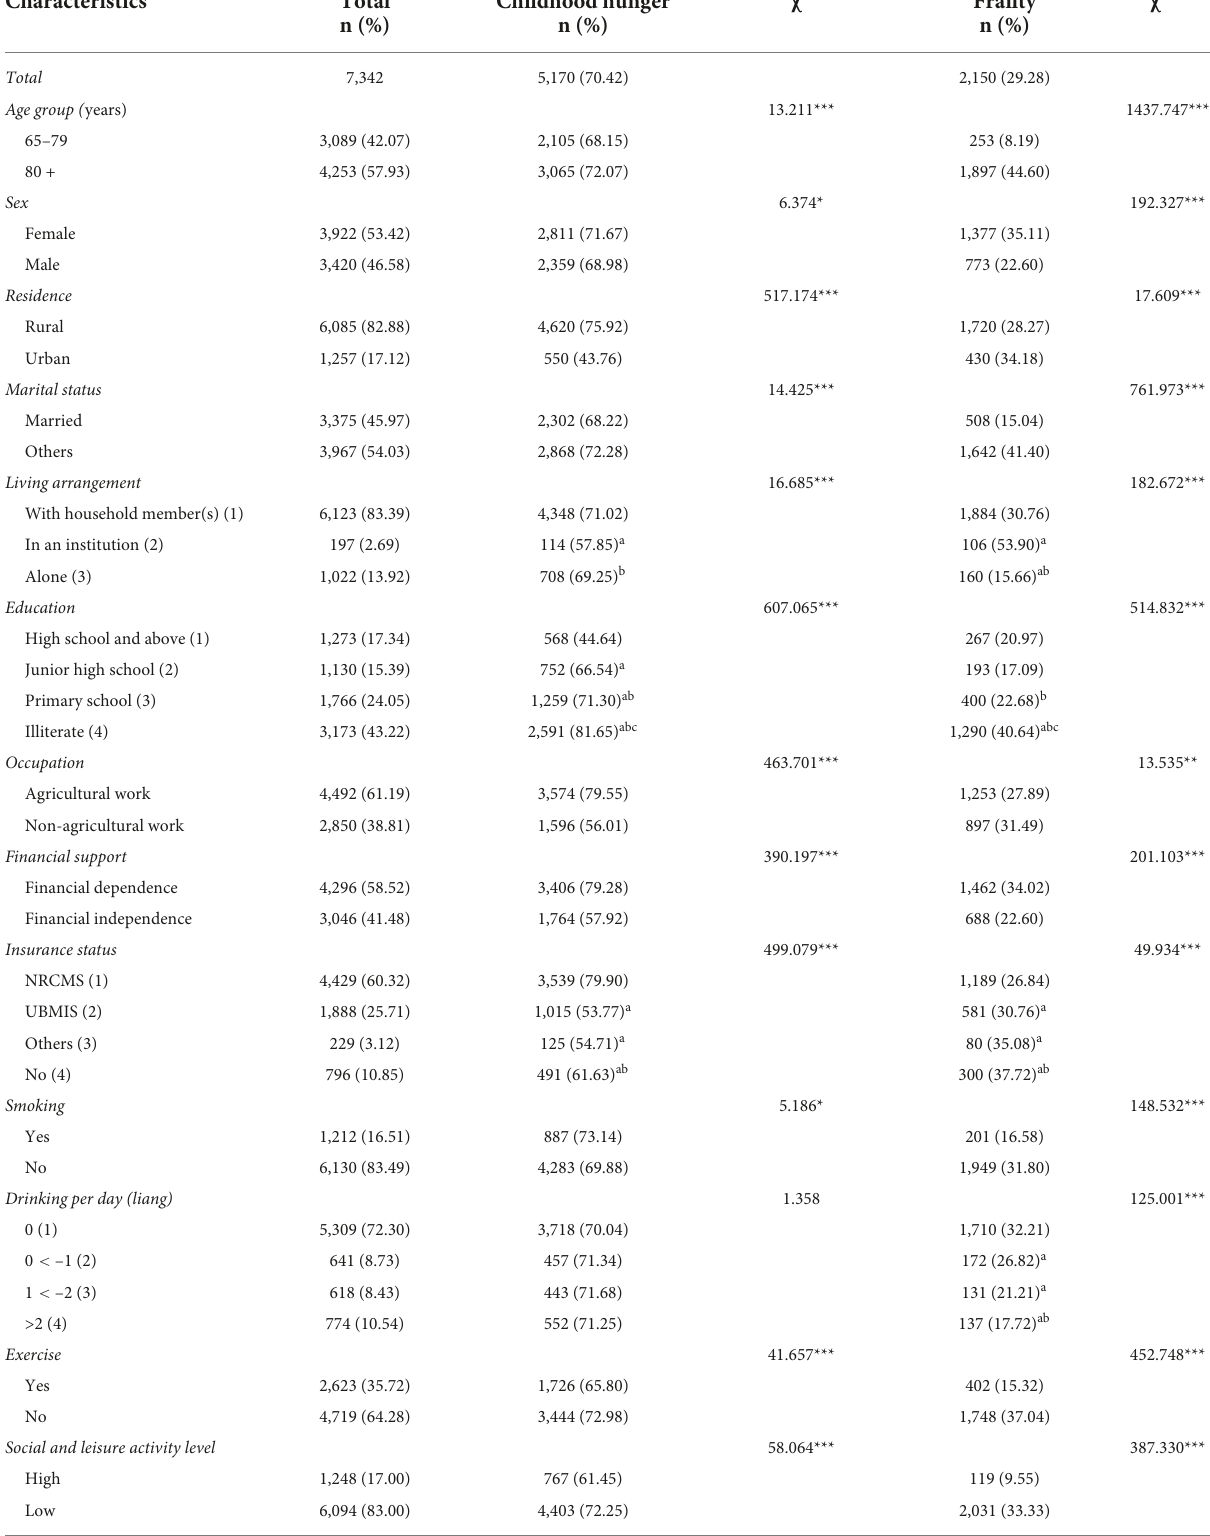
TABLE 2 Association of baseline characteristics with childhood hunger and frailty; data are expressed as number (prevalence) [n (%)].